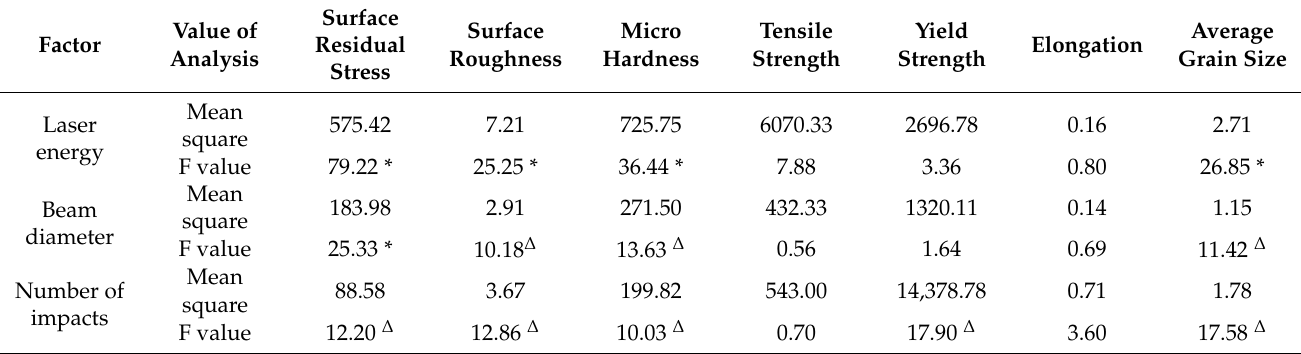
Table 5. Variance analysis of different indicators.